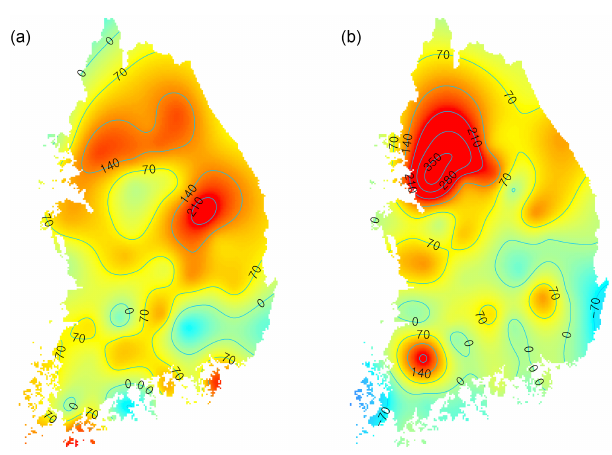
Figure 6. Spatial distributions of annual mean precipitation differ- ence between the validation period (1994–2008) and the test pe- riod (1976–1993) for the observed data (left panel) and the IBB- simulated data (right panel).